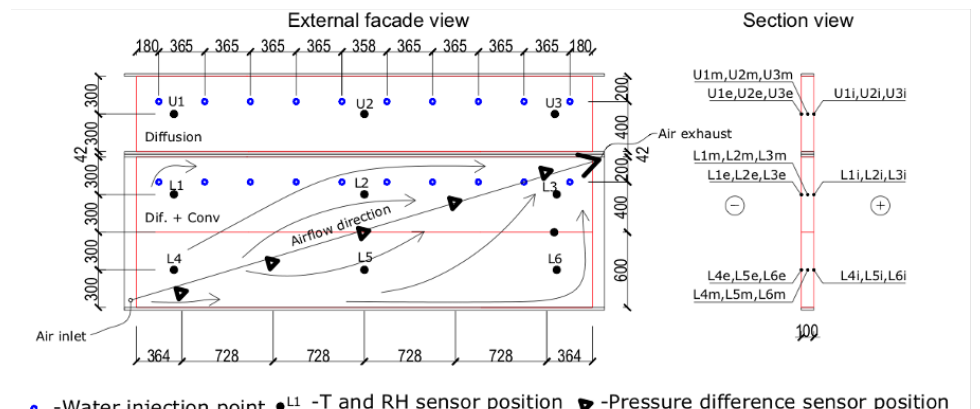
Figure 2. Full scale test walls and sensor positioning (T/RH Humisense A1, airflow SMC PFM